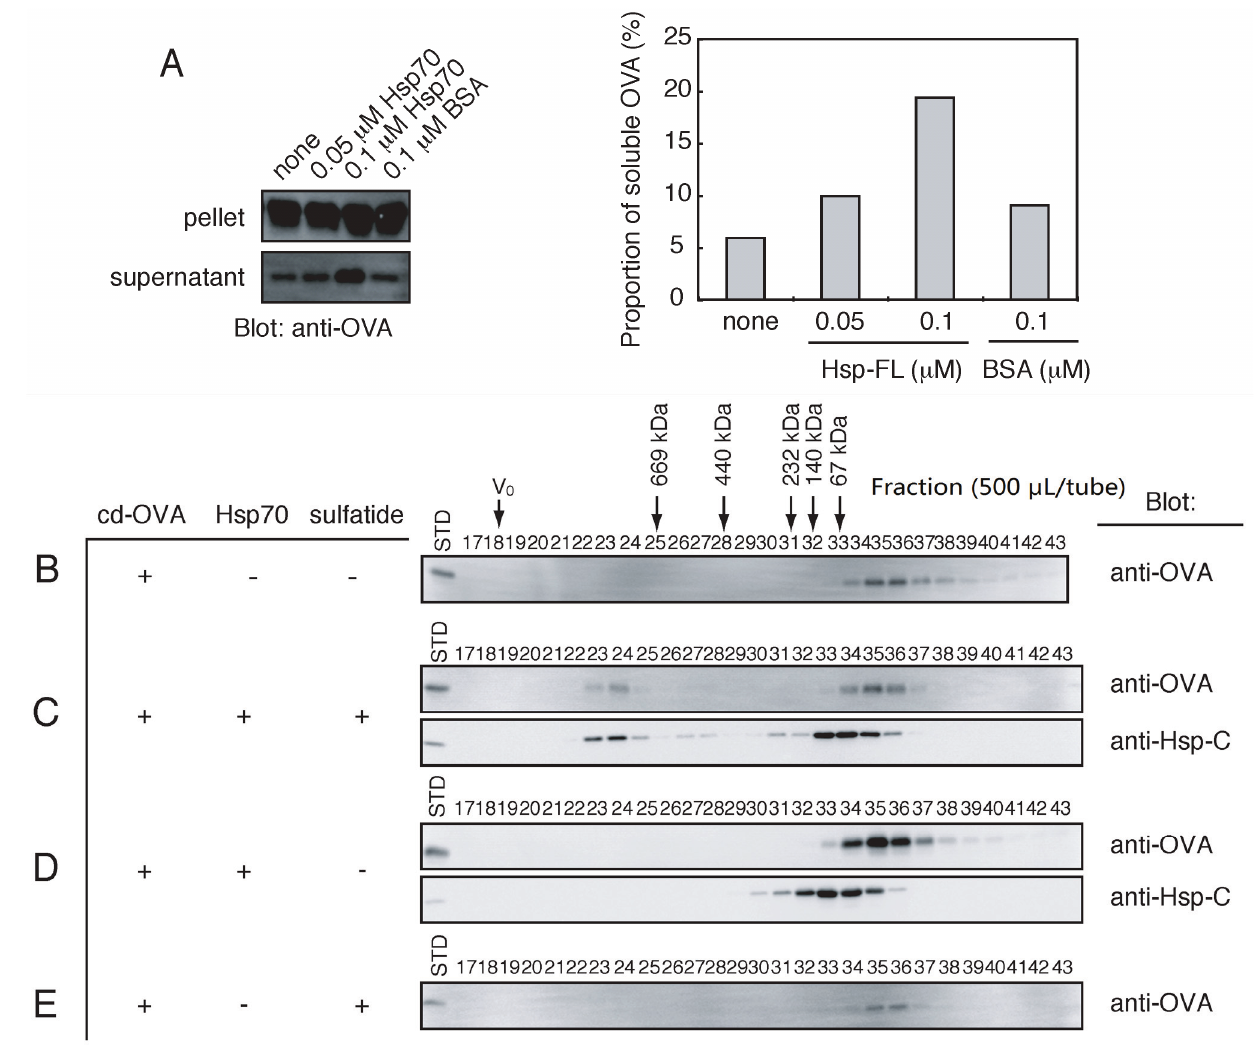
Figure 5. Sulfatide-induced formation of the HMW Hsp70 stabilizes the binding between Hsp70 and chemically denatured ovalbumin (cd-OVA). ( A ) Hsp70 or bovine serum albumin (BSA) was incubated with cd-OVA for 30 min at 42 °C. After centrifugation, the supernatant (sup.) and the pellet (ppt.) fractions were analyzed by SDS-PAGE, followed by Western blot using anti-OVA antibody (left panel). Total intensity of cd-OVA was set to 100% and the relative amounts of cd-OVA in the supernatant fraction (soluble OVA) were indicated (right panel); ( B – E ) Hsp70, sulfatide, and cd-OVA were incubated as indicated combinations and separated by gel-filtration chromatography. Fractions (500 (cid:2)L) precipitated with TCA and external standards (STD; Hsp70, 35 ng; cd-OVA, 10 ng) were analyzed by Western blot using anti-Hsp-C and anti-OVA antibodies. V 0 indicates void volume. Thyroglobulin (669 kDa), Ferritin (440 kDa), catalase (232 kDa), aldolase (140 kDa) and albumin (67 kDa) were used as molecular weight